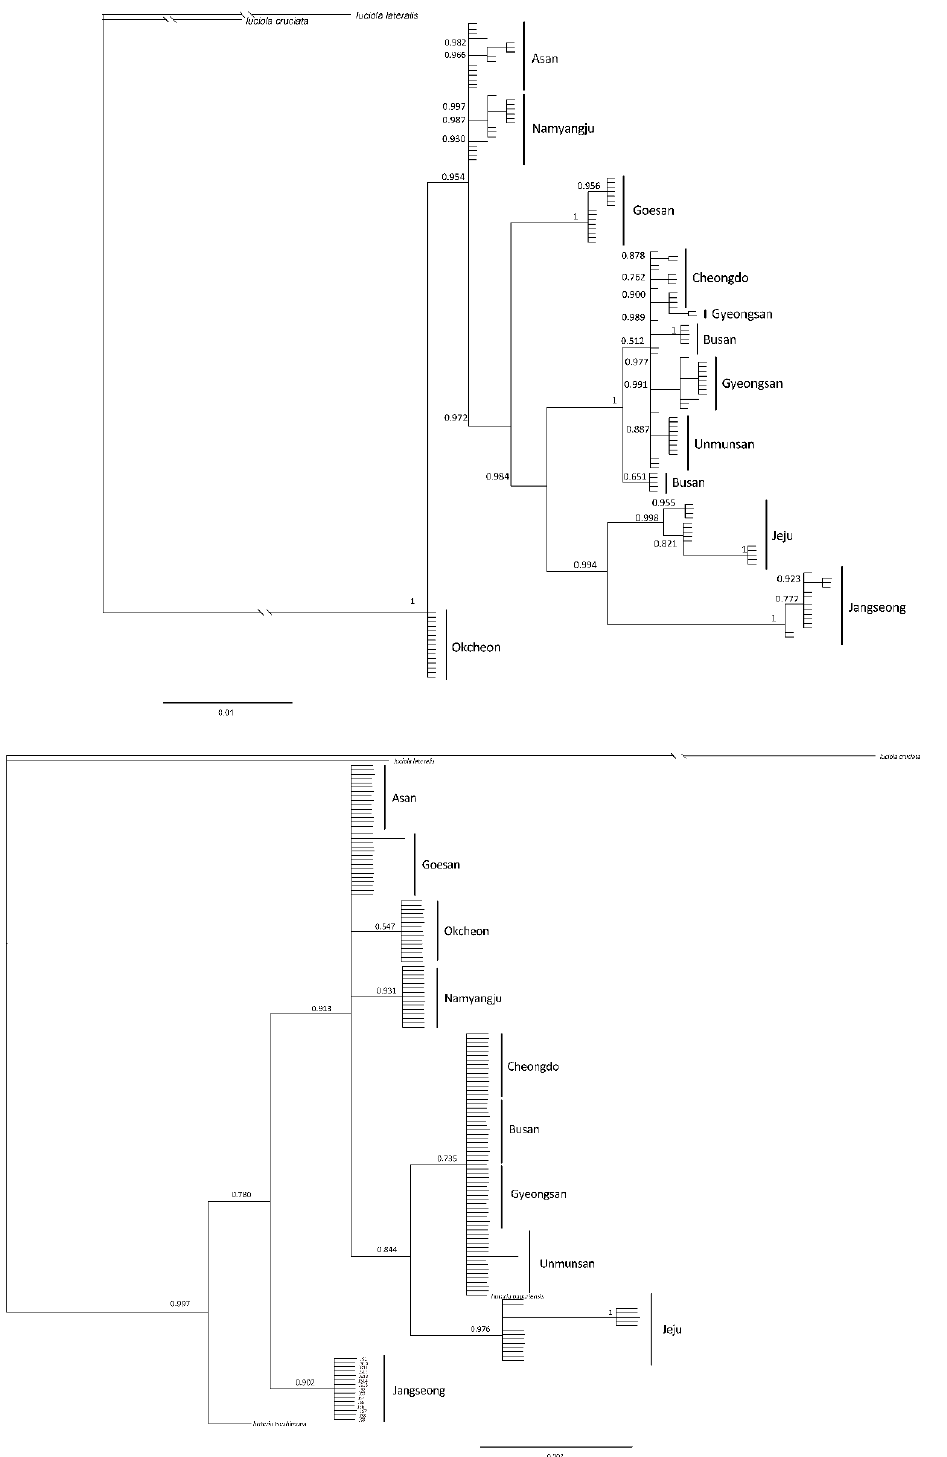
Figure 8. Phylogenetic analysis of 27 mitochondrial COII gene ( upper tree ) and 9 mitochondrial 16s rRNA gene ( under tree ) of L. unmunsana . The trees were developed by the Bayesian inference method using the Mrbayes software.